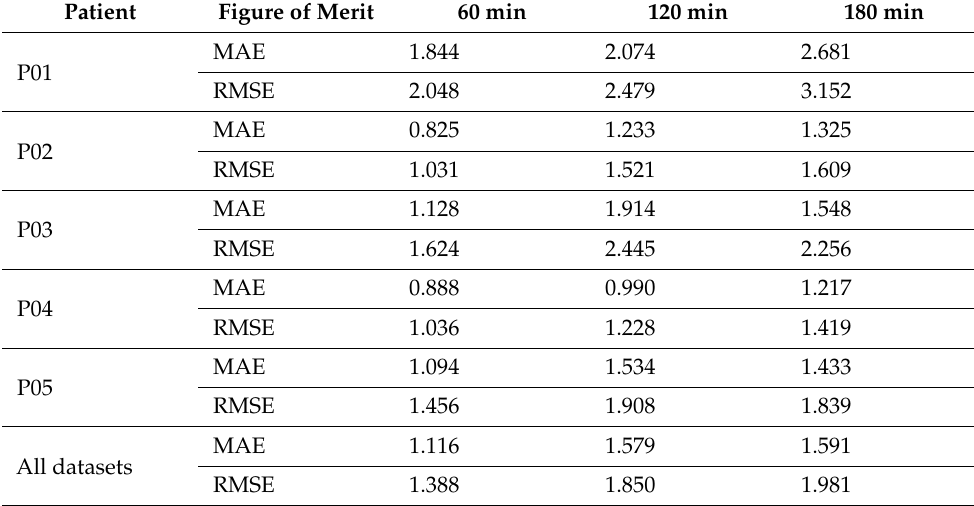
Table 5. RMSE and MAE results with the AUC version on four horizons, all values in